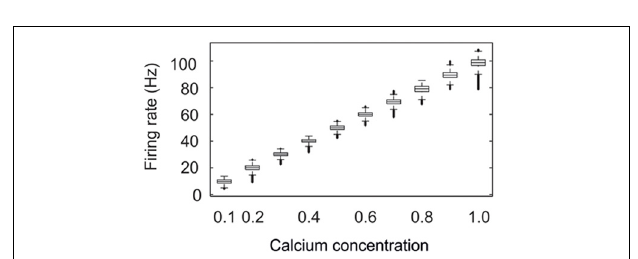
FIGURE 3 | Neurons develop their connectivity in order to reach a homeostatic set-point (cid:2) of intracellular calcium. The figure shows the firing rates attained for different set-point values of calcium. For each calcium concentration, the firing rates of all neurons were pooled from four different simulations recorded over the last 20,000ms. The central mark of each box is the median firing rate; boxes represent the 25th and 75th